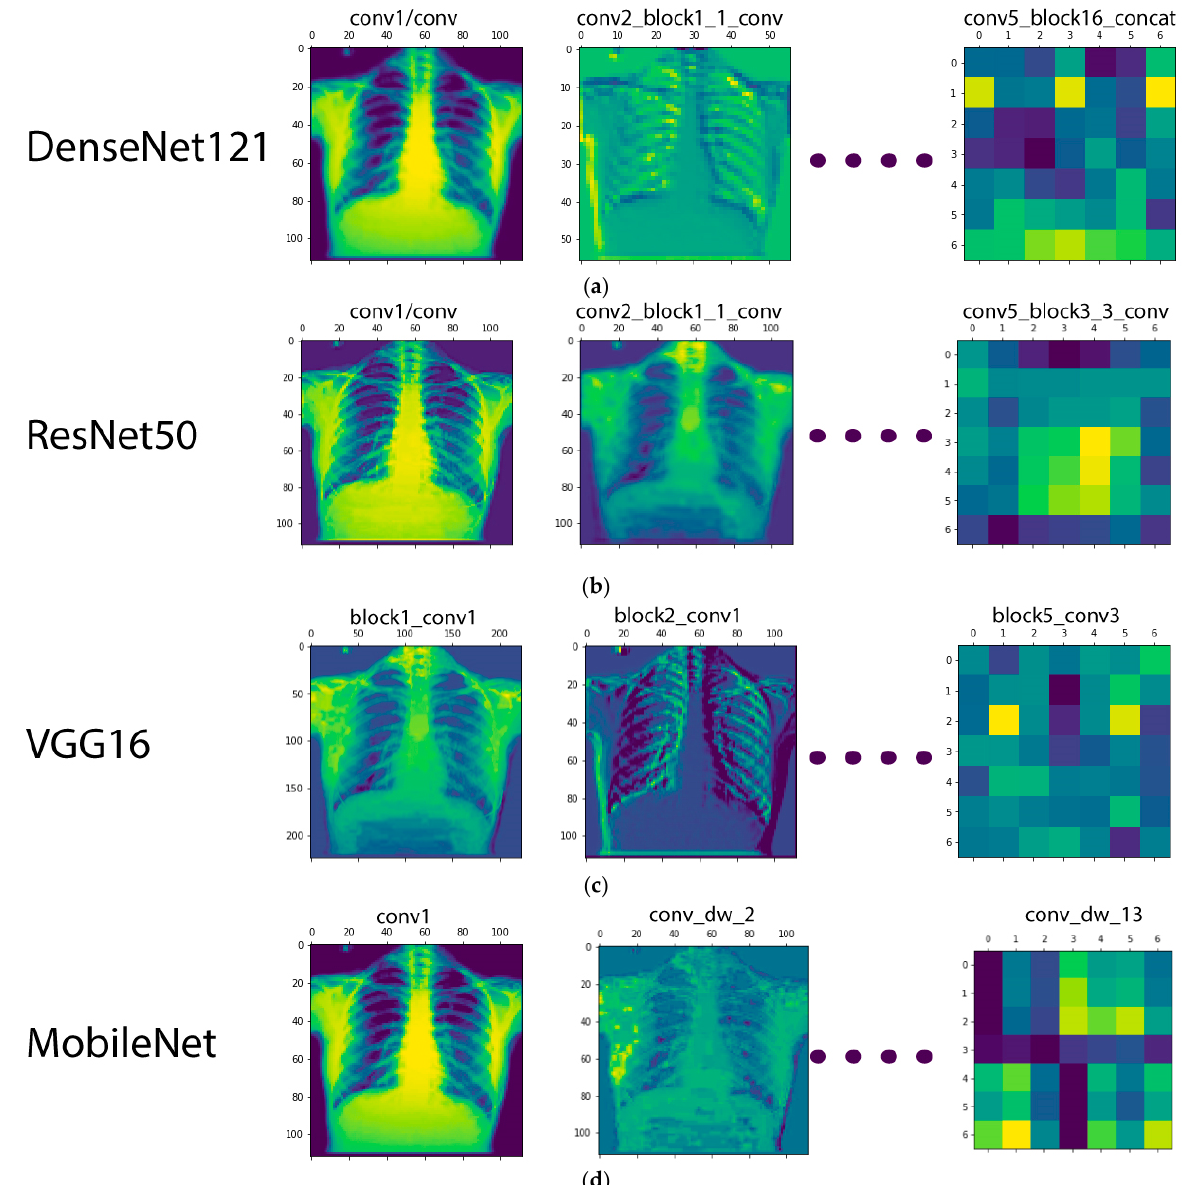
Figure 6. Visualization of the feature maps for the CNN models used in this study: ( a ) DenseNet-121; ( b ) ResNet-50; ( c ) VGG16; ( d )